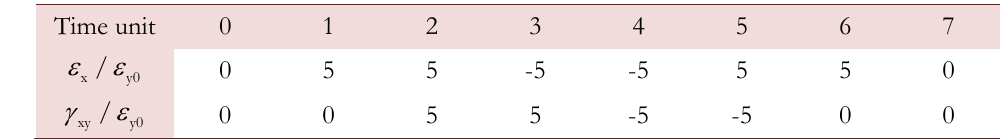
Table 1: Pointwise mixed stress-strain test. Controlled strain history: in between two next time units, strain components vary